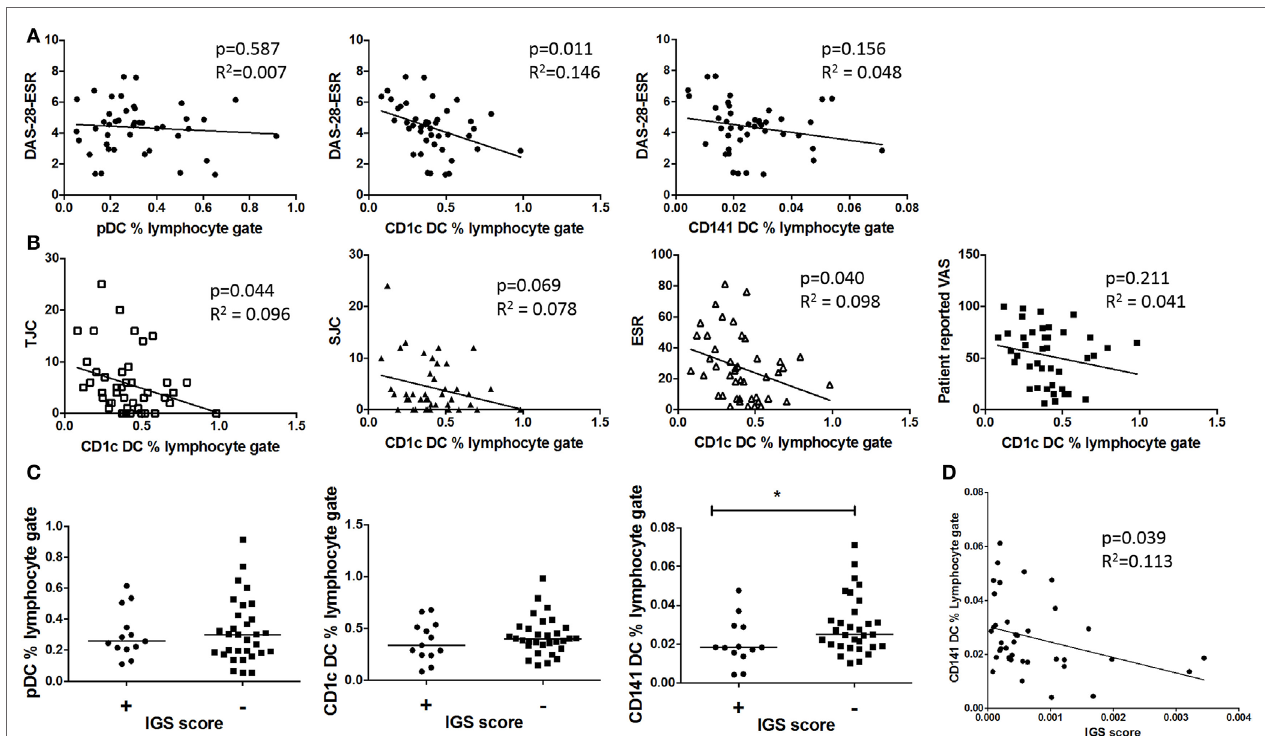
FigUre 2 | Only circulating CD1c + DC frequencies inversely associate with disease activity and CD41 + DC but not pDC frequencies inversely associate with the interferon gene signature (IGS) (a) Plots depict linear regression of pDC, CD1c + DC, and CD141 + DC frequency and disease activity (DAS-28-ESR) in early rheumatoid arthritis (RA) ( n = 42). (B) : Individual DAS-28-ESR components are examined with relation to CD1c + frequency (linear regression) (c) Early RA patients ( n = 39) peripheral blood DC frequency divided by IGS (positive n = 13 and negative n = 26). Horizontal lines depict median values. Mann–Whitney U tests. (D) Linear regression of CD141 + DC frequency and IGS score. DAS-28, disease activity score 28; ESR, erythrocyte sedimentation rate; SJC, swollen joint count; TJC, tender joint count; VAS, visual analog